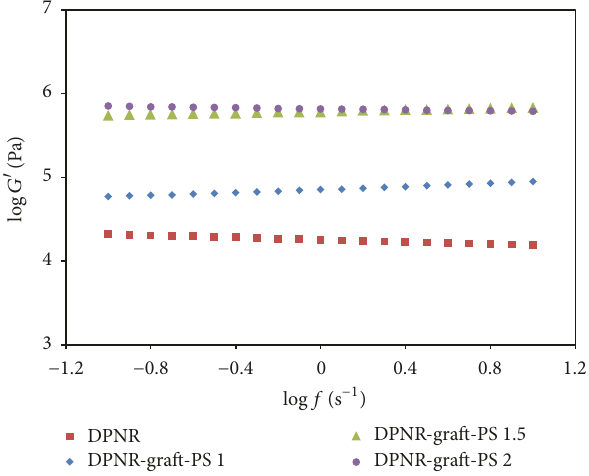
Figure 3: Frequency dependence of storage modulus for DPNR and DPNR- graft -PS at 30 ∘ C.